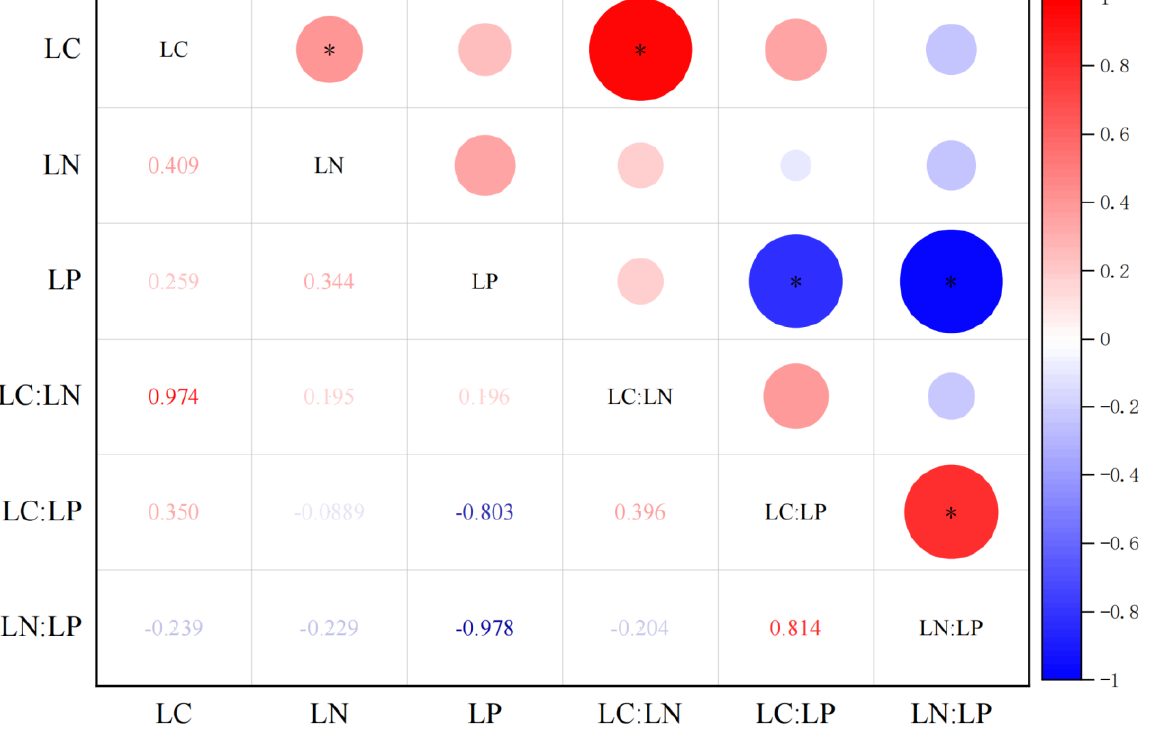
Figure 3. Correlation of LC, LN, and LP contents and stoichiometric characteristics of Moso bamboo when expanding into Chinese fir forests (* represent significance levels of p < 0.05).